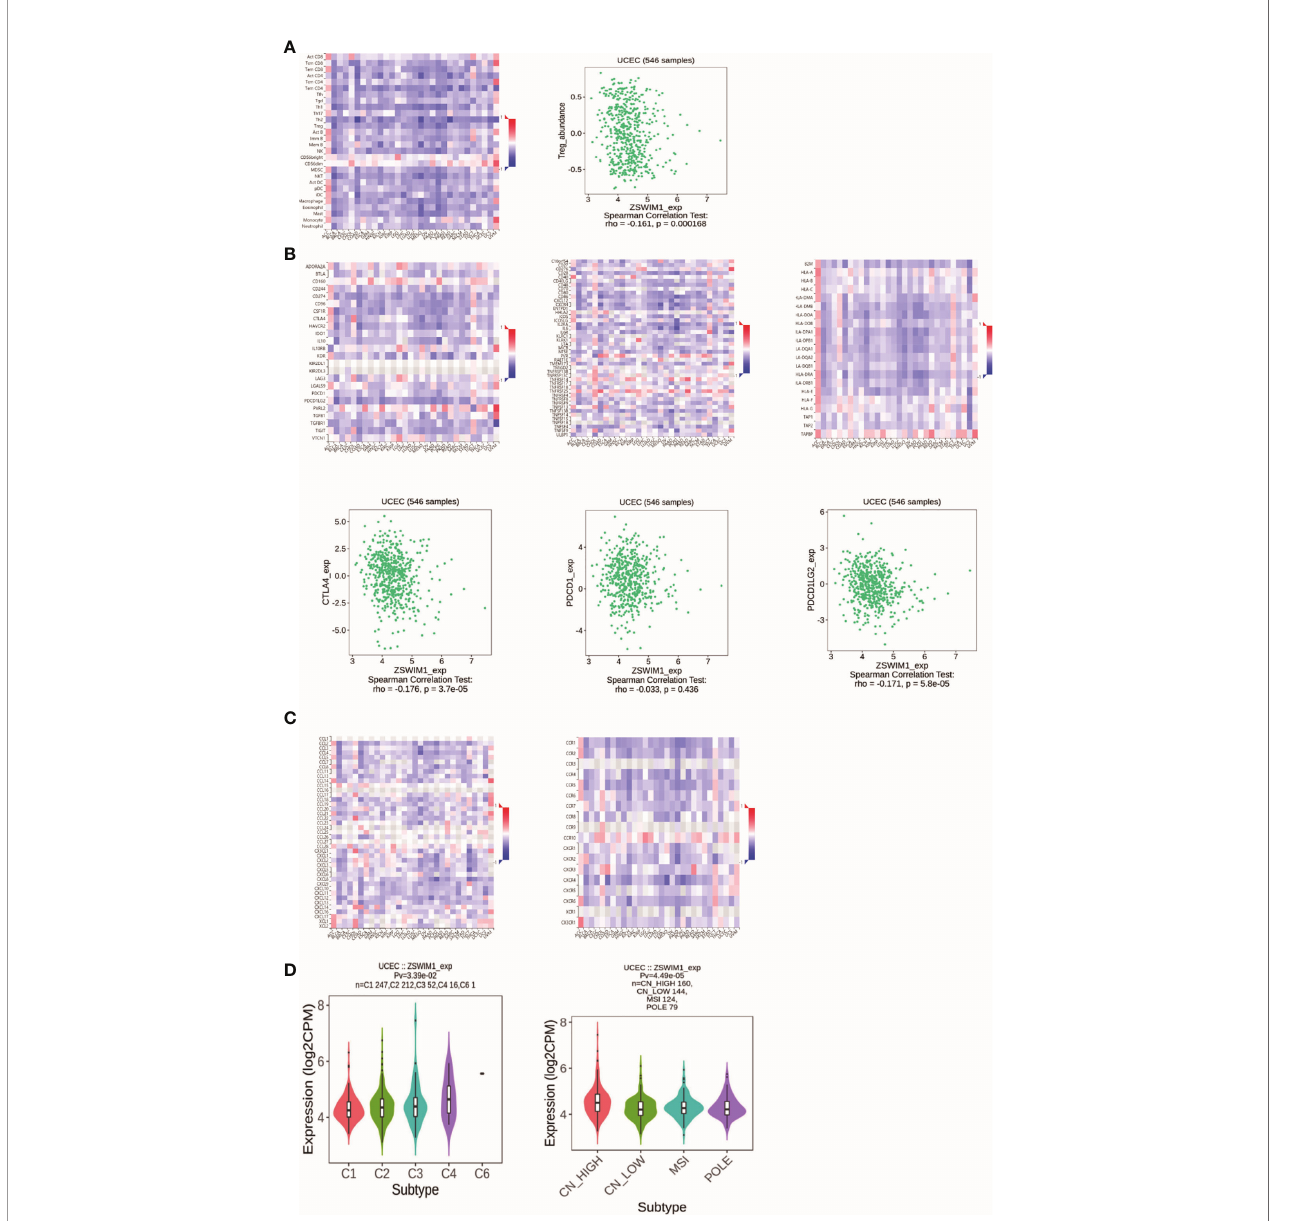
FIGURE 12 | The results of immunoassay for ZSWIM1. (A) The landscape of relationship between ZSWIM1 expression and TILs in different types of cancer (red is positive correlation, and blue is negative correlation). (B) The relationship between ZSWIM1 expression and immunomodulator. (C) The relationship between ZSWIM1 expression and chemokine. (D) The relationship between ZSWIM1 expression and